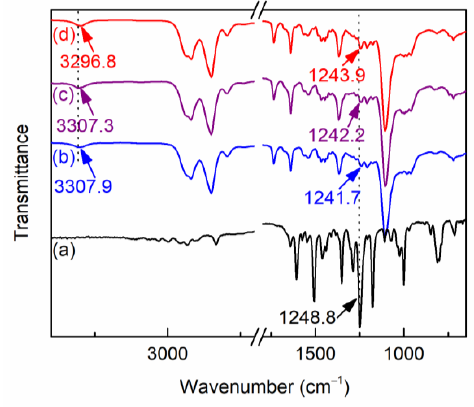
Figure 2. FTIR spectra of T( p -OCH 3 )PPCoCl ( a ), Pebax-2533 membrane ( b ), 0.6 wt% T( p - FTIR spectra of T( p -OCH 3 )PPCoCl ( a ), Pebax-2533 membrane ( b ), 0.6 wt % T( p -OCH 3 )PPCoCl / Pebax-2533 membrane ( c ) and 2 wt % T( p -OCH 3 )PPCoCl / Pebax-2533 membrane ( d ).